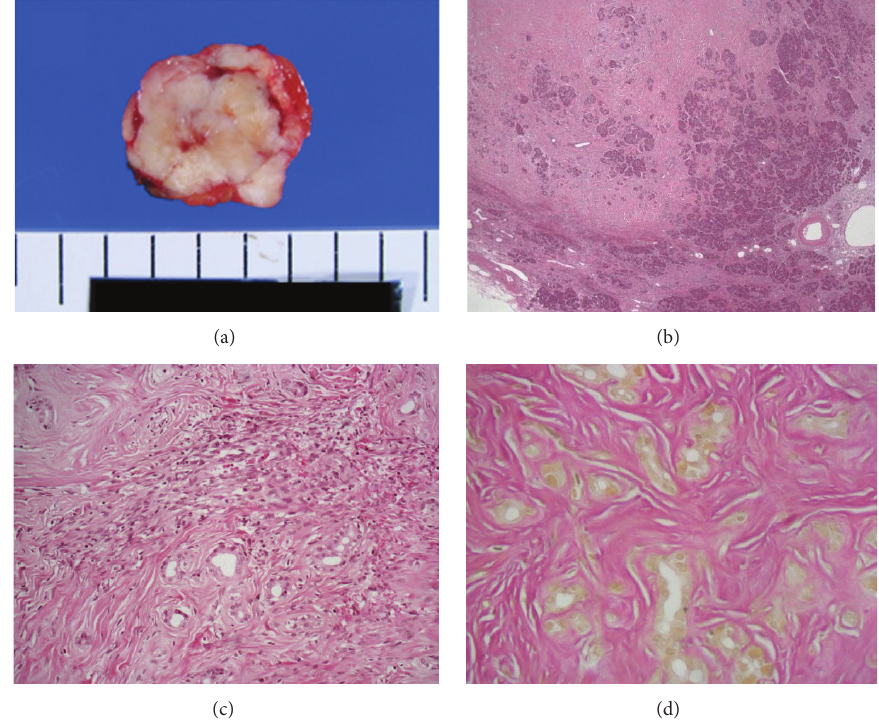
Figure 1: (a) Gross appearance of the surgical specimen showing a well-demarcated and vaguely lobulated ivory-white tumor. (b) Pancreatic parenchyma was haphazardly distributed in the tumor. (c) Spindle cells proliferated in heavily collagenized fibrous stroma. (d) Concentric elastic fibers in the duct walls were not evident with Elastica van Gieson